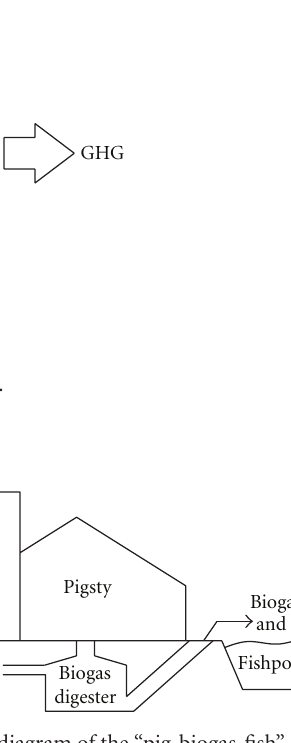
Figure 2: A schematic diagram of the “pig-biogas-fish”